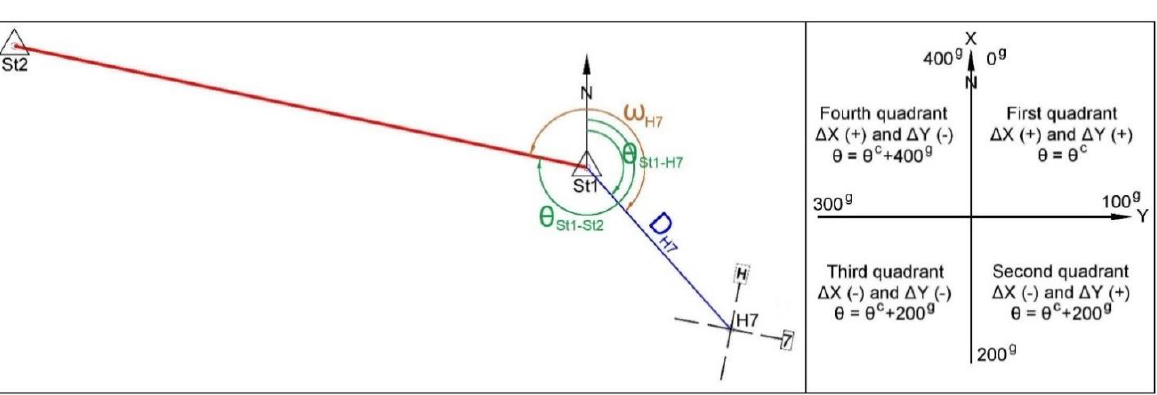
Figure 4. Polar coordinates for layout point H7 and the topographic quadrants for the calculus.